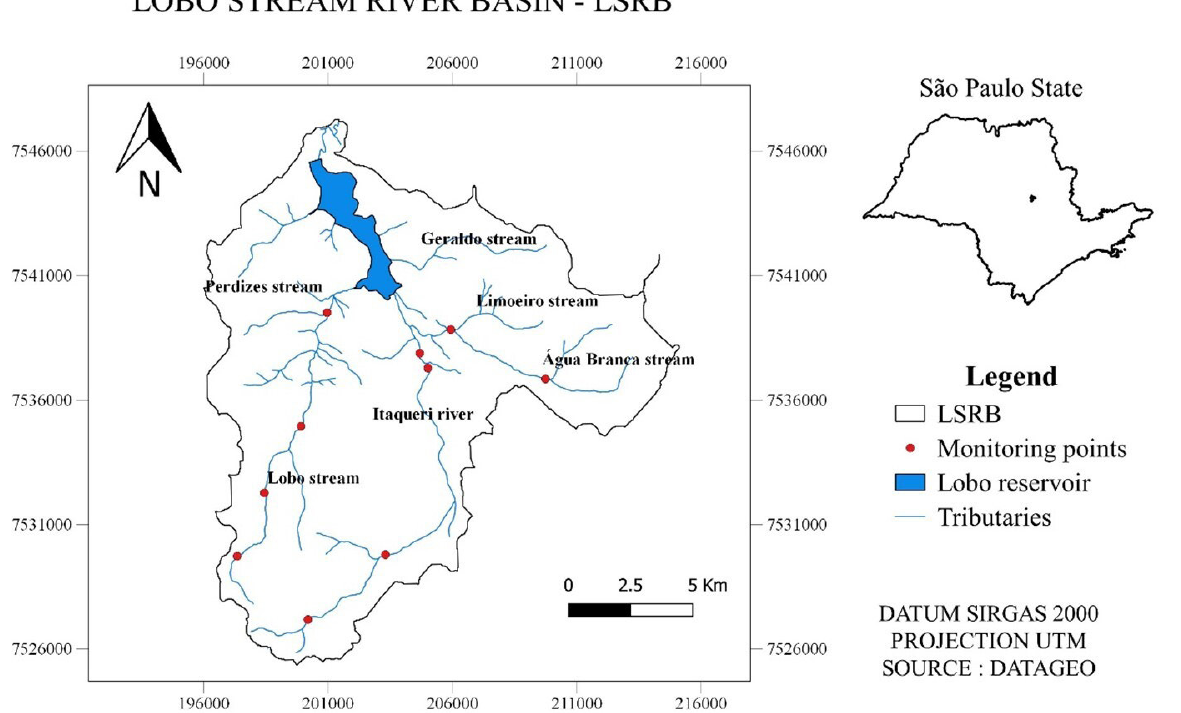
Figure 1. Location and hydrography of LSRB and monitoring